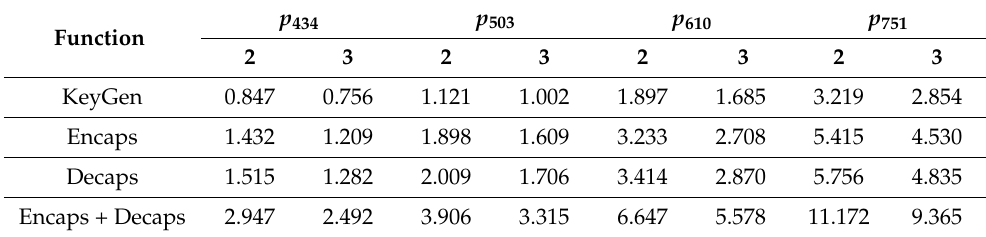
Table 6. Performance of the scalable isogeny accelerator under different parameter